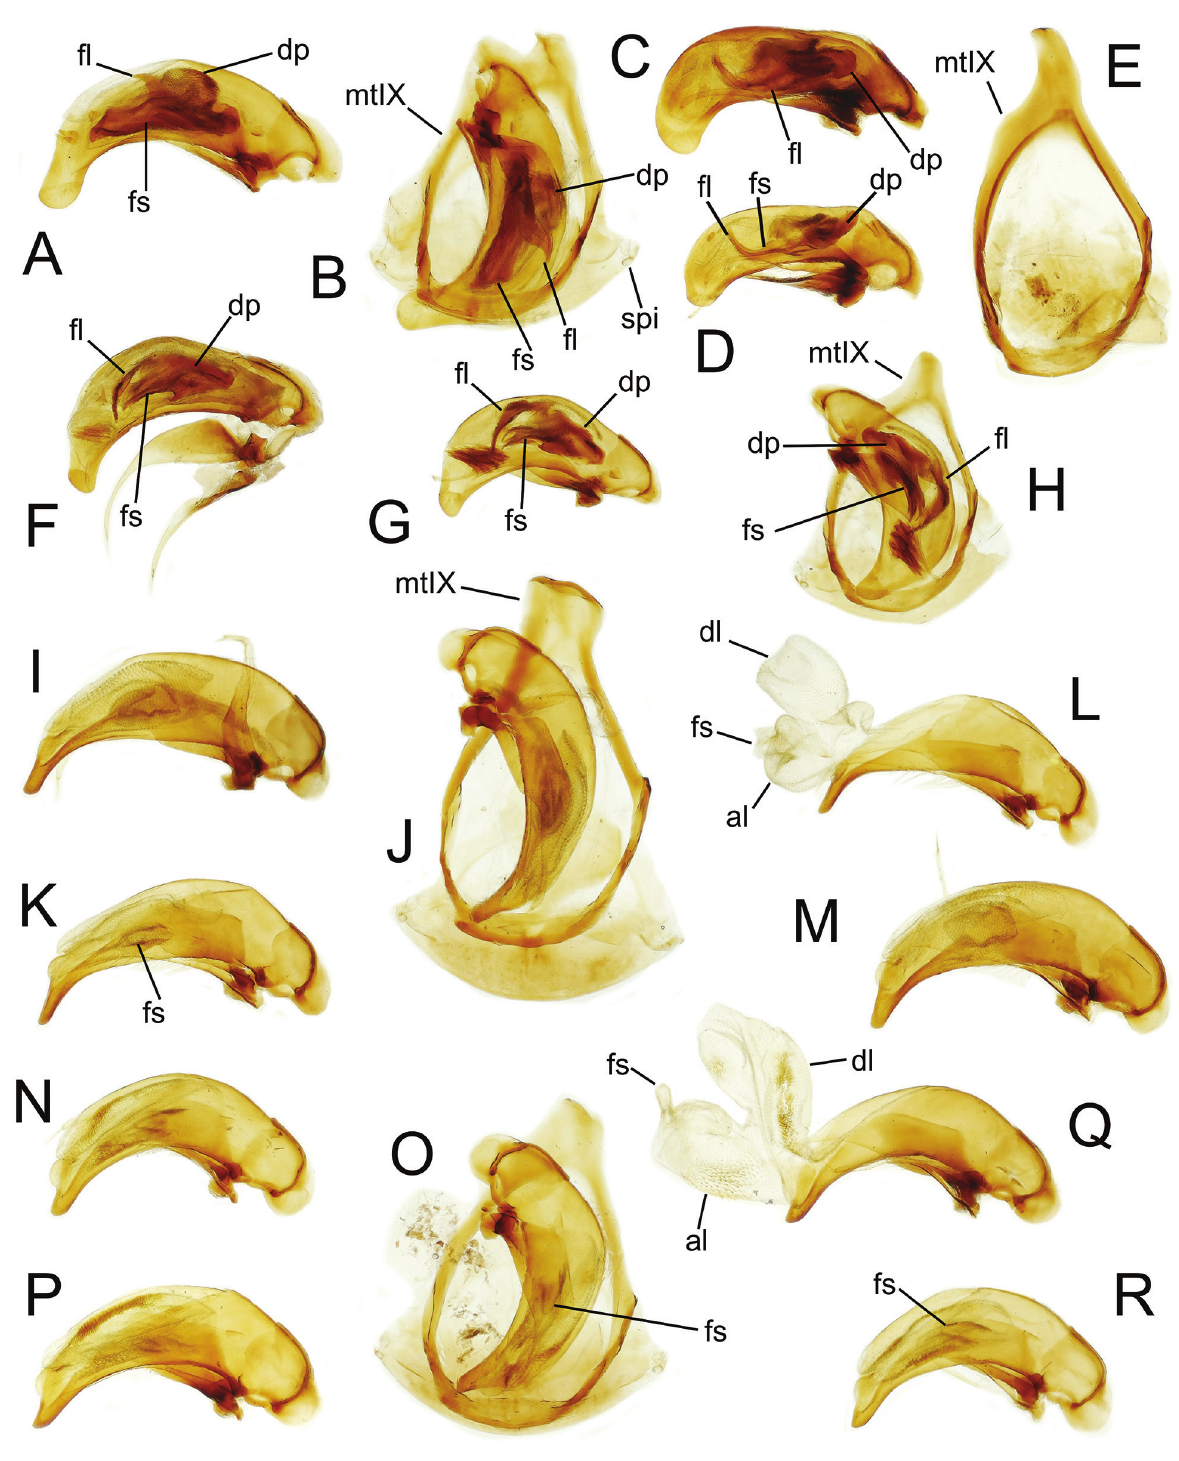
Figure 10. Male aedeagal median lobe and parameres, and ring sclerite–mediotergite plus antecostal margin, tergite IX–of Mecy- clothorax ( Phacothorax ) spp.: A–B , M. laterorobustus , right view, dorsal view in situ (Ningua); C , M. laterosinuatus , right view (Col d’Amieu); D , M. laterosinuatus , right view (Touho TV tower); E , M. laterosinuatus ring, dorsal view; F , M. laterorectus , right view (Mt. Panié); G–H , M. laterorectus , right vew, dorsal view in situ (Mandjélia); I–J , M. fleutiauxi , right view, dorsal view in situ (Mt. Do); K–L , M. fleutiauxi , right view, sac inverted and everted (Me Maoya); M , M. fleutiauxi , right view (Ningua); N–O , M. jeanneli , right view, dorsal view in situ (Mt. Humboldt, 1350 m); P , M. jeanneli , right view (Mt. Humboldt, 1300 m); Q , M. jeanneli , right view, sac everted (Mt. Dzumac); R , M. jeanneli , right view (Rivière Bleue). See Table 2 for